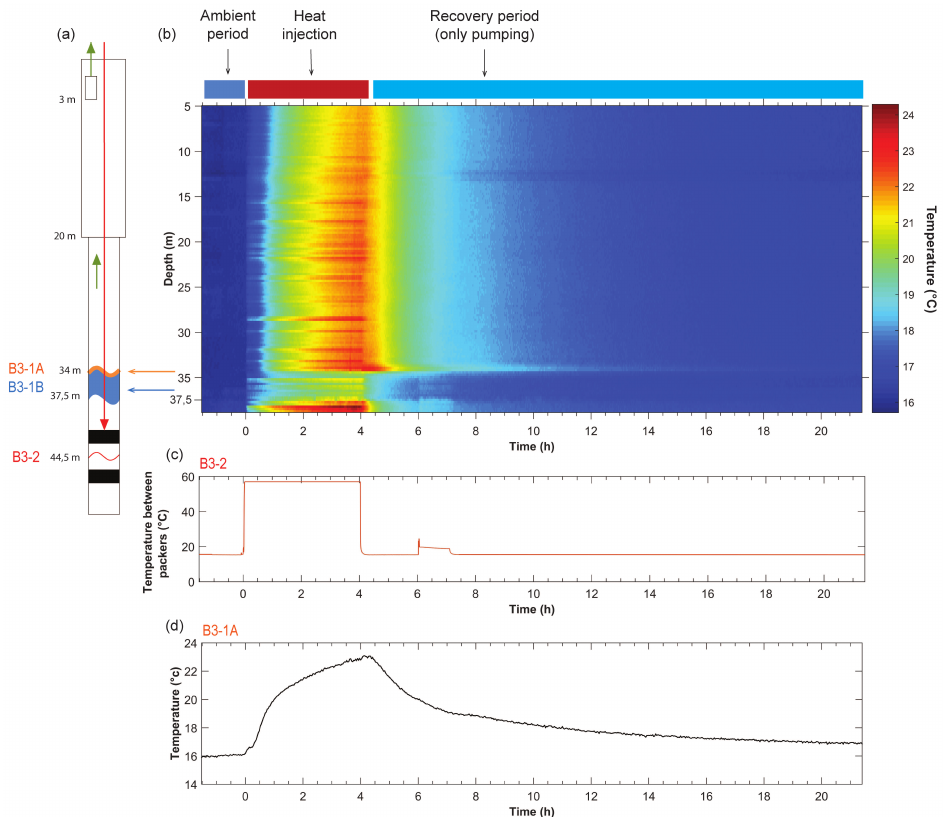
Figure 4. ( a ) B3 borehole scheme with the position of the pump (3 m), the injection fracture B3-2 (in red), the hot inflow B3-1A (in orange) and the cold inflow B3-1B (in blue) interpreted from ( b ) the measured temperature with the fiber-optic distributed temperature sensing (FO-DTS) during Experiment III, where the x axis represents the time during the experiment, and the y axis corresponds to the depth in the borehole, ( c ) temperature measured in the injection chamber at B3-2 depth and ( d ) thermal breakthrough superimposed with thermal losses signal measured with the FO-DTS at B3-1A (34